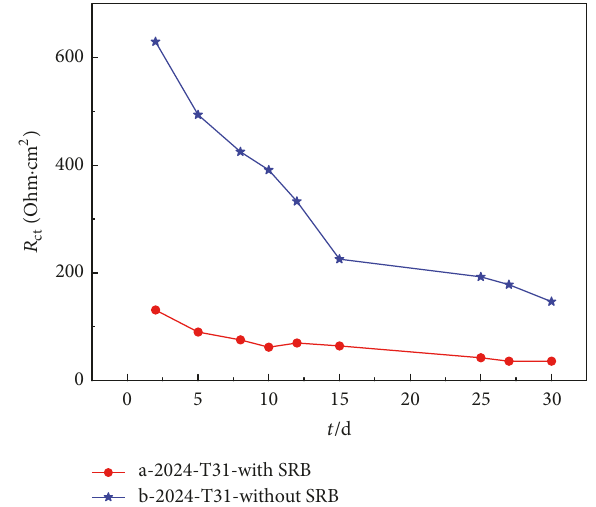
Figure 7: The evolution of 𝑅 ct of 2024-T31 aluminum-magnesium alloy in different medium